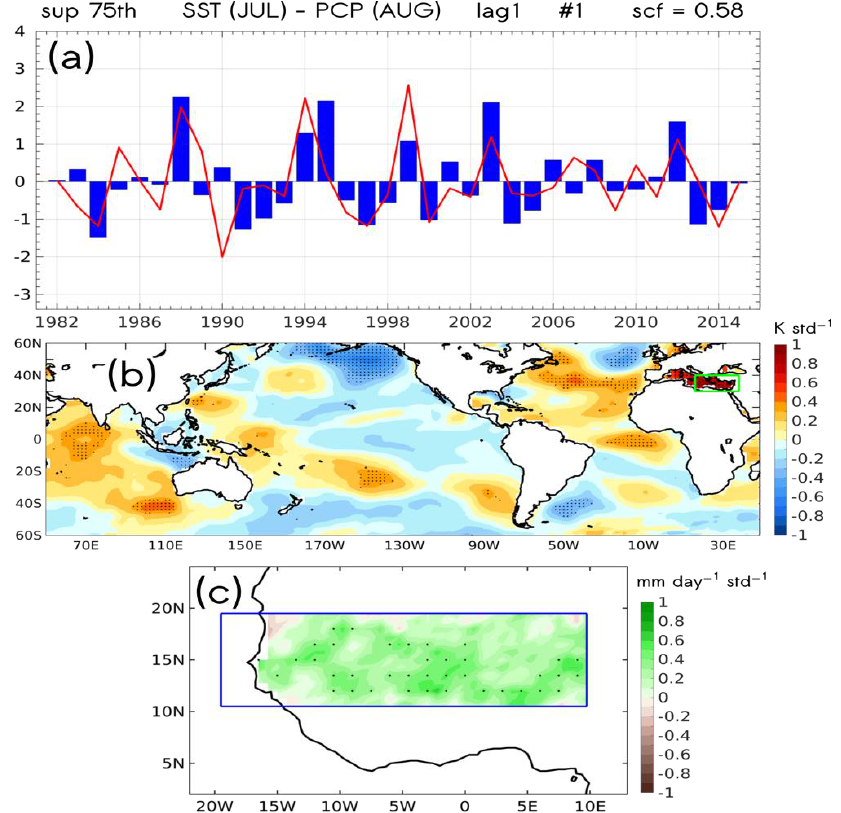
Figure 3. Leading MCA mode calculated between the Eastern Mediterranean SSTA (16 ◦ –38 ◦ E; 30 ◦ –40 ◦ N) in JUL (lag 1) and the anomalous Sahel (20 ◦ W–20 ◦ E; 10 ◦ –20 ◦ N) rainfall above the 75th percentile in AUG. ( a ) Time series expansion coe ffi cients for SST (U; blue bars) and rainfall (V; red line) for the leading JUL-AUG MCA mode. ( b ) Homogeneous SSTA (K std − 1 ) map calculated by regression of SST expansion coe ffi cient U onto global SSTA. Green contoured box denotes the region taken into account for MCA. ( c ) Heterogeneous map of anomalous rainfall (mm day − 1 std − 1 ) calculated by regression of SST expansion coe ffi cient U onto regional anomalous Sahelian rainfall. Stippling denotes 95% (0.05) statistical significance under a Monte Carlo test (1000